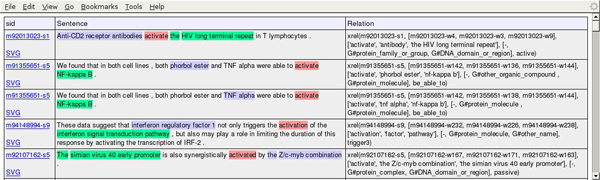
Sample Output. Sample output for the 'activate' relation.